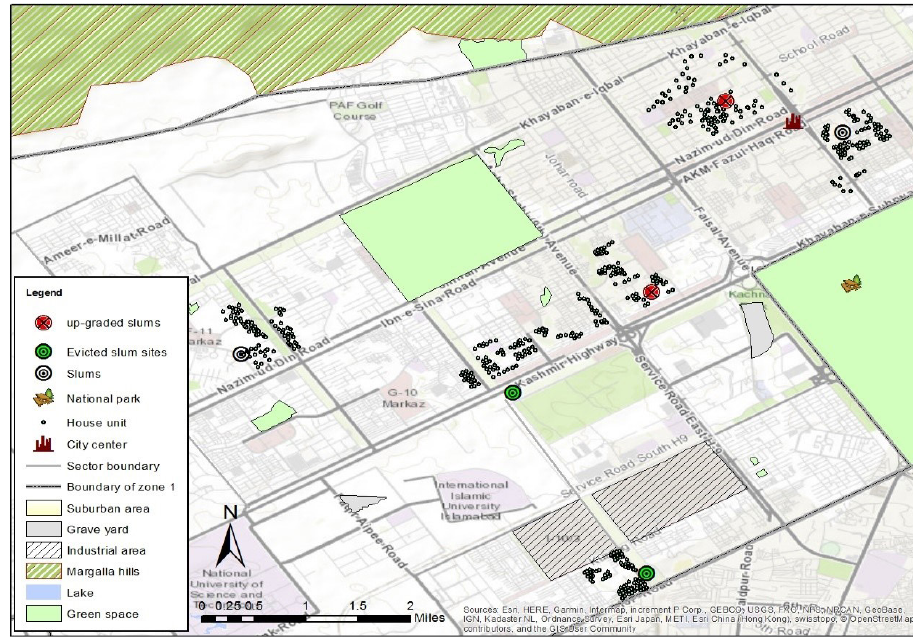
Figure 2. Selected sample houses in the study